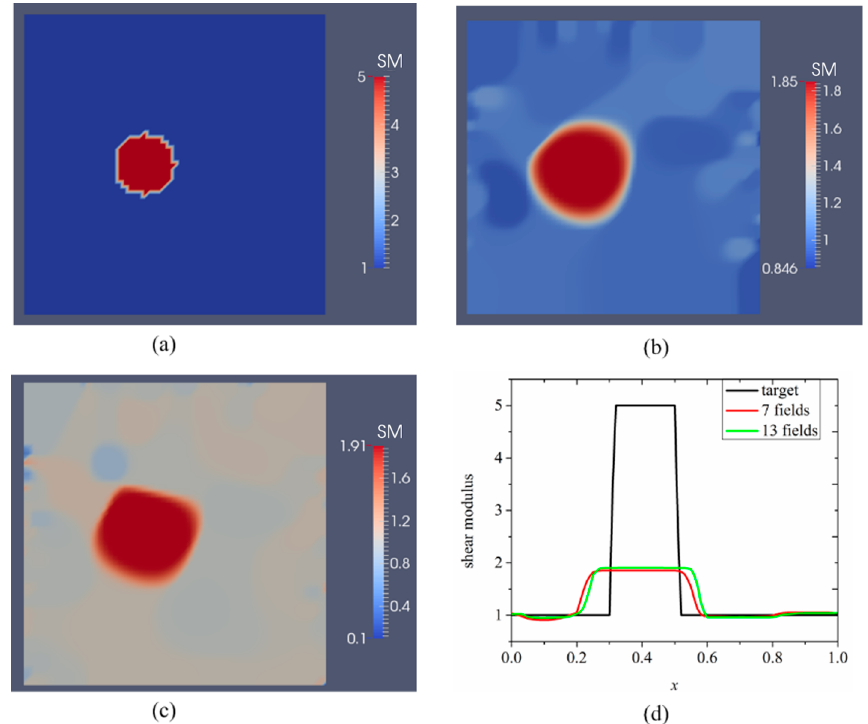
Figure 3. Shear modulus reconstructions for 1.0% noise. ( a ) target shear modulus distribution for comparison; ( b,c ) reconstructed shear modulus distribution using 7 and 13 boundary displacement data sets, respectively; ( d ) shear modulus plot over the horizontal line through the center of the inclusion for the target and reconstructed shear modulus distribution (unit in the scale bar: 10 kPa). Note: “SM” stands for shear